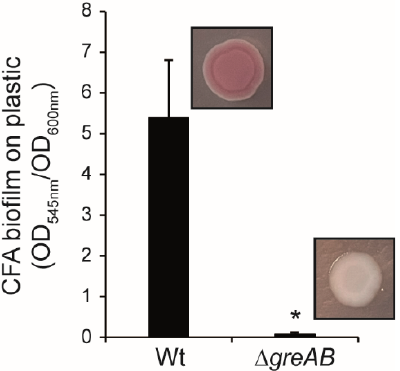
Figure 3. The Gre factors are required for expression of rdar biofilm promotion in Escherichia coli . A. Effect of deletion mutants of Gre factor encoding genes on biofilm formation by E. coli MG1655 strain. Quantification of crystal violet stained biofilm formed on polystyrene walls of 96 well plates by MG1655 (Wt) and its Δ greAB mutant grown in CFA medium for 72 h at 25 °C. Insets show the colony morphotype of the indicated strains on Congo red plates. Biofilm quantification values are mean and standard deviations of six samples. Statistical significance to Wt is shown by an asterisk ( p < 0.0005).